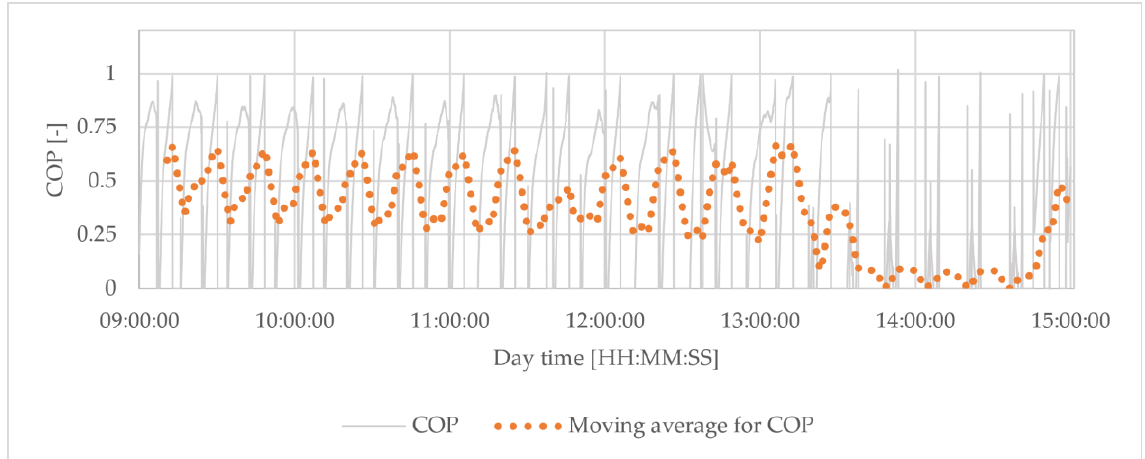
Figure 20. COP values over time for 11th August.